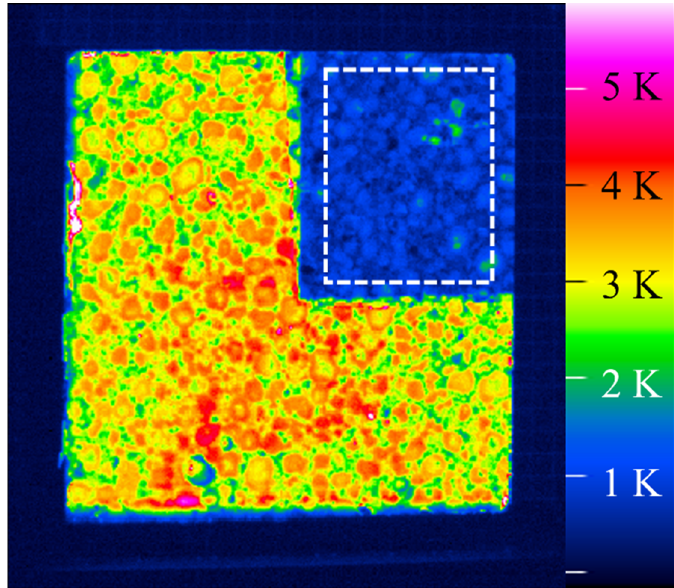
Figure 8. First difference thermogram of the type 1 sample after the pulse had started (heating duration < 25 ms). The white dashed rectangle includes the measurement region for the temperature transients.